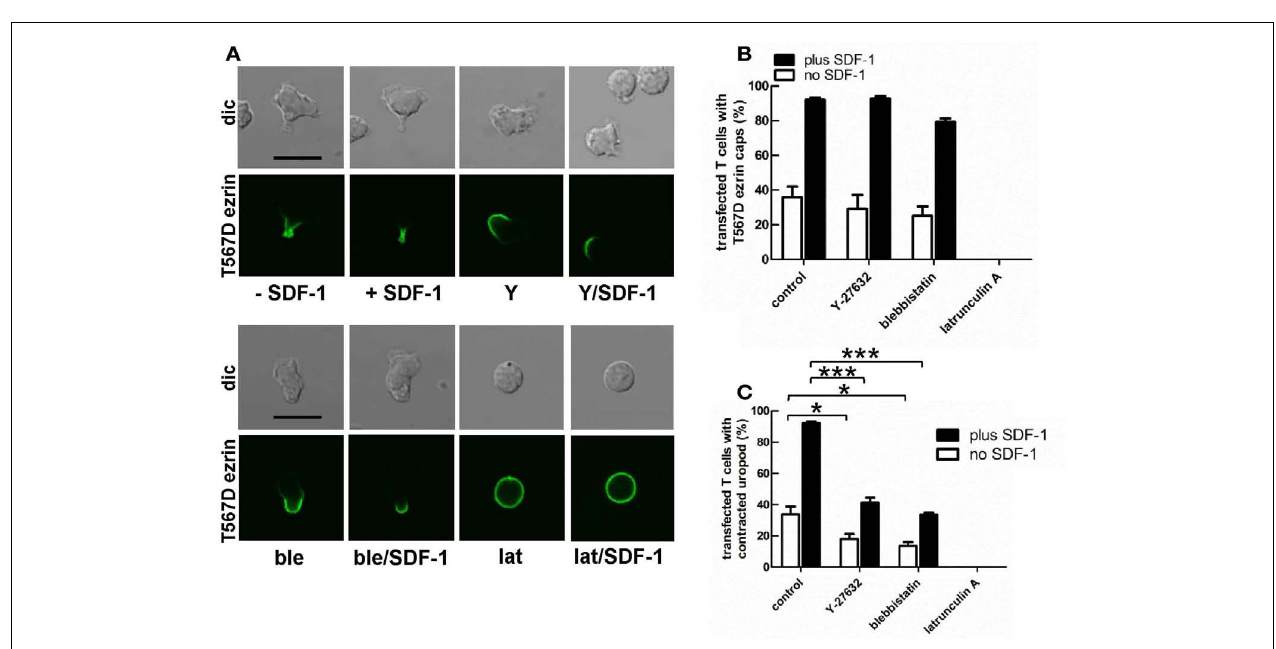
absence or presence of SDF-1 (40ng/ml) for 15min.T cells were then fixed with PFA, followed by confocal microscopy (A) .The % of transfected cells withT567D ezrin-EGFP caps (B) and the % of transfected cells with contracted uropods (C) was evaluated. Bar, 10 µ m (B,C) : mean ± SEM of three to seven independent experiments). * P < 0.05; *** P < 0.001 for statistically significant differences between data as